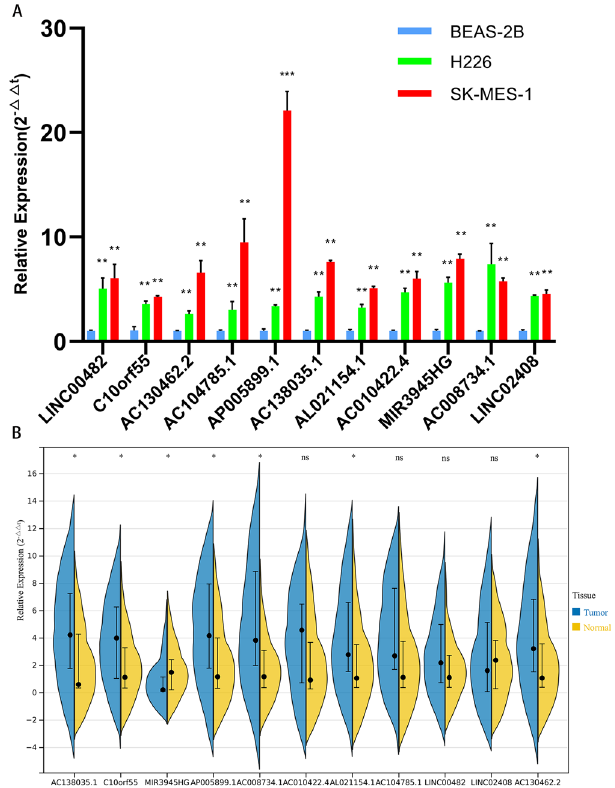
Figure 11. The expression validation of the lncRNAs in the signature. ( A ) Expression levels of 11 pyroptosis- related lncRNAs in the normal lung epithelial cell line BEAS-2B and two LSCC cell lines (A549, NCI-H1975) by RT-qPCR. ( B ) Expression levels of 11 pyroptosis-related lncRNAs in LSCC tissues and matched para- cancerous tissues by RT-qPCR. lncRNA long non-coding RNAs, LSCC lung squamous cell carcinoma, RT-qPCR quantitative real-time polymerase chain reaction. *P < 0.05, **P < 0.01, ***P <